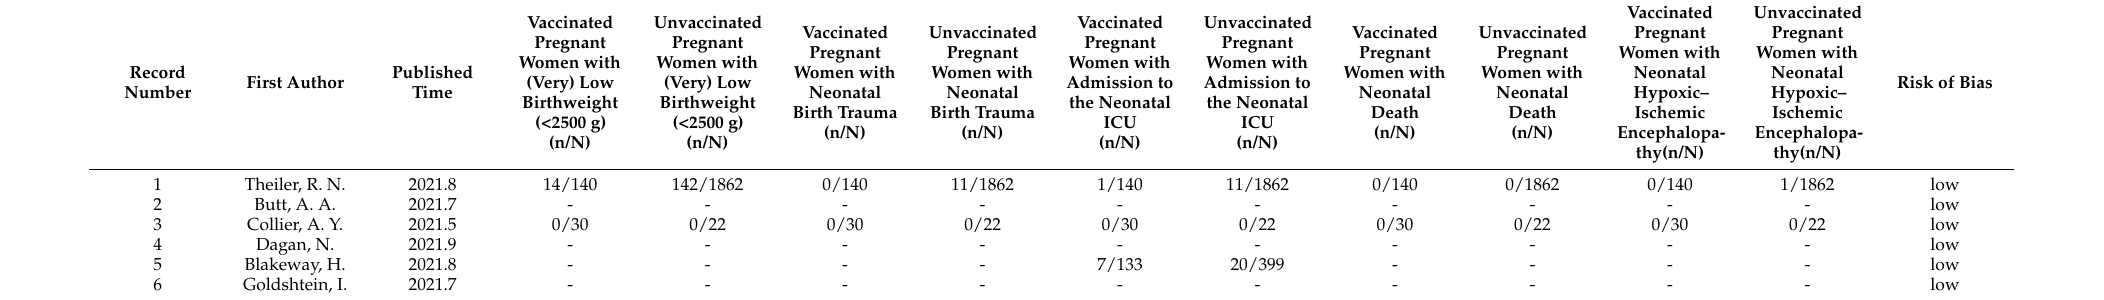
Table 4. Findings of included original studies for adverse neonatal